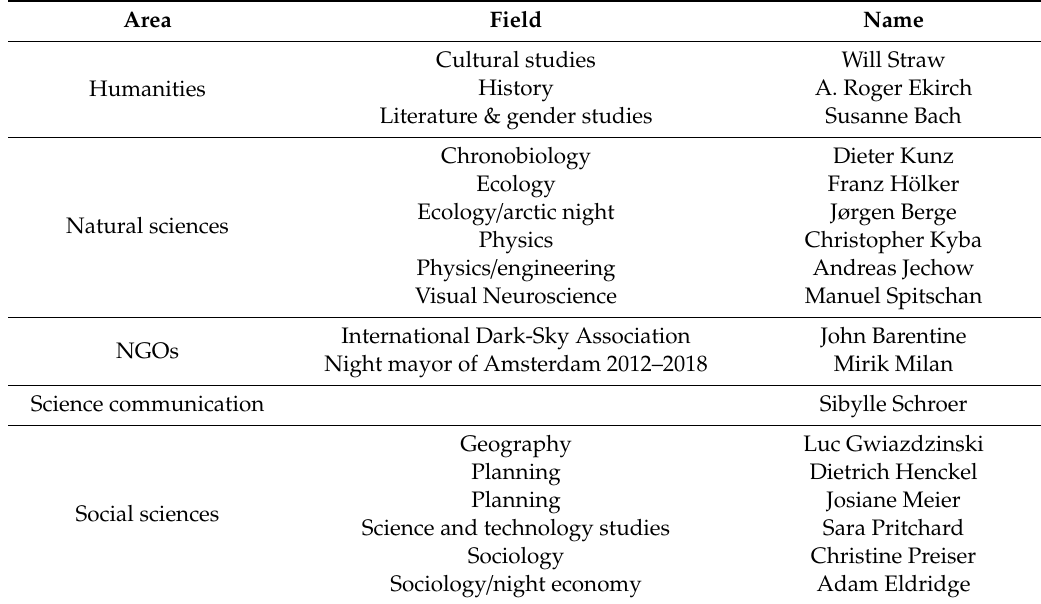
Table A1. Areas of main activity of the